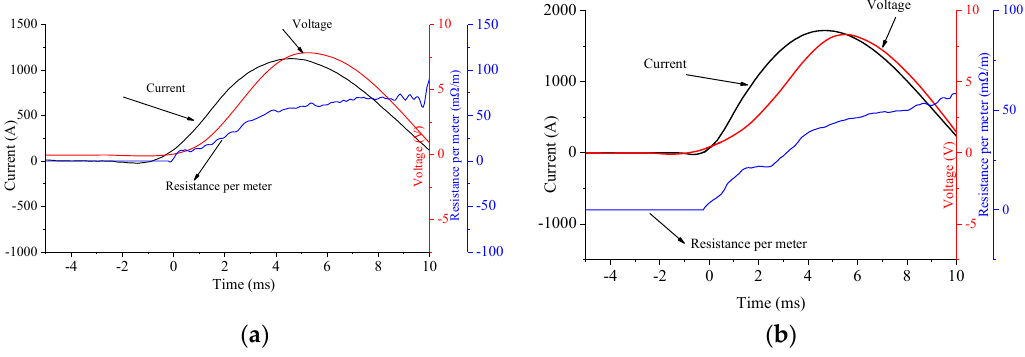
Figure 6. Current, voltage, and resistance waveforms of 75.9 mT. ( a ) SC_SH. ( b ) SC_8602.